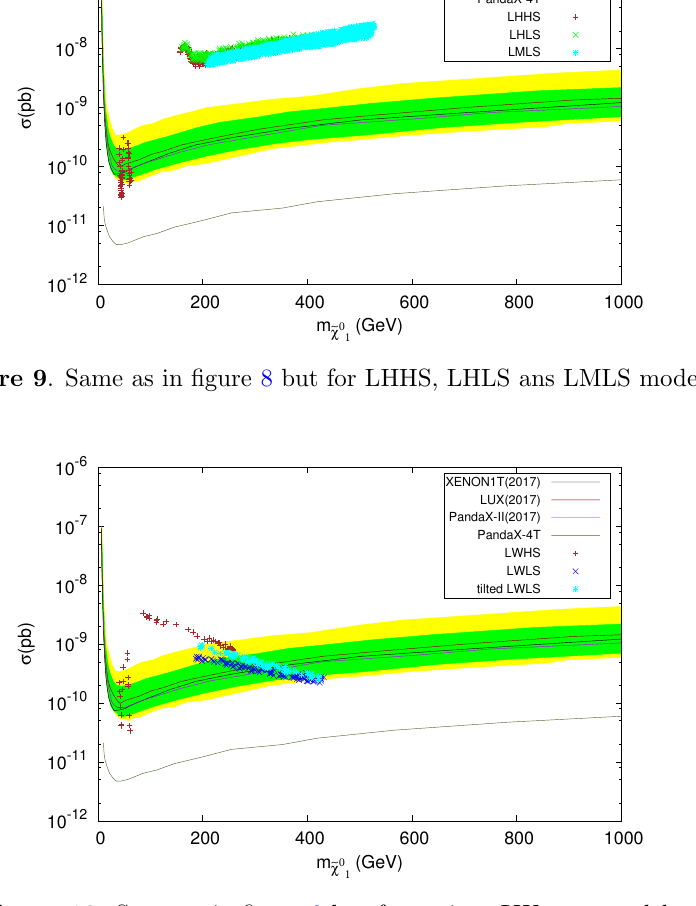
Figure 10 . Same as in (cid:12)gure 8 but for various LW type